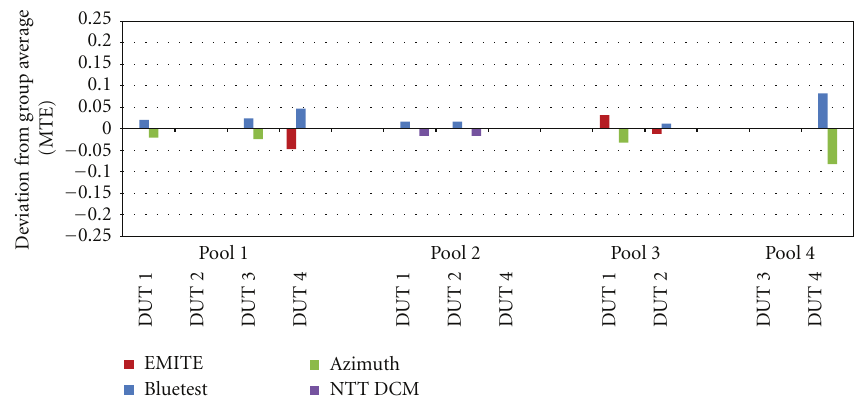
Figure 6: Deviation from group average (MTE STD) for the RC methodology.